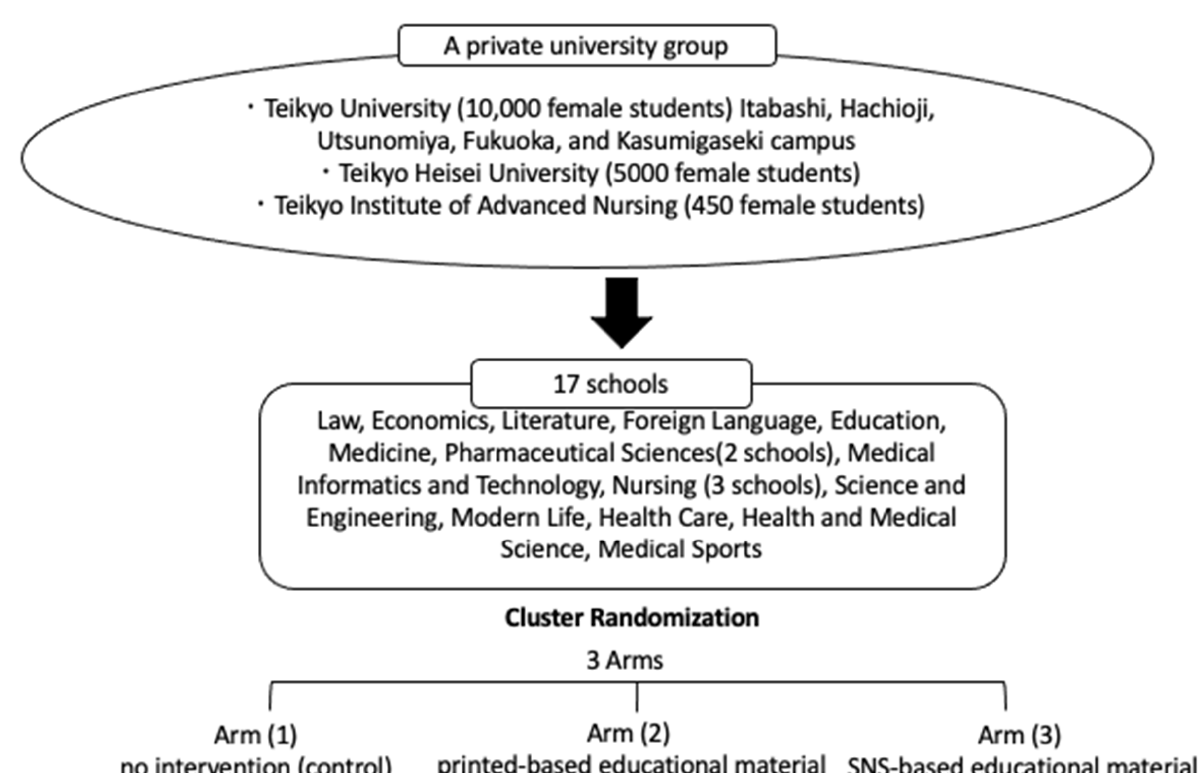
Figure 1. Study Figure 1. Study flowchart.